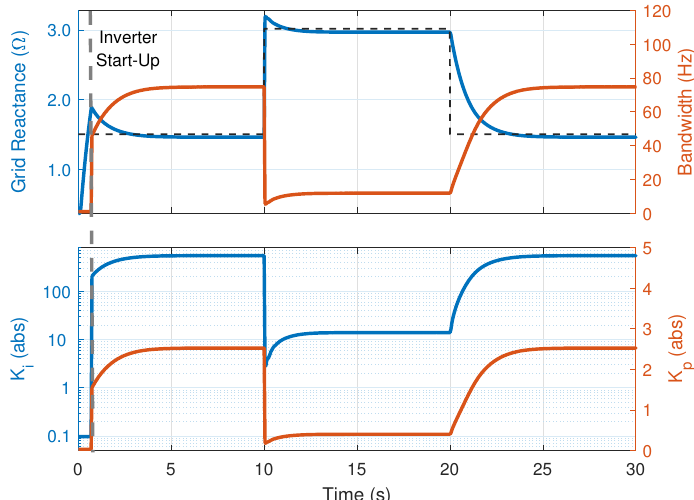
Figure 9. Real-time measurement (blue) of grid reactance, its known value (black dashed), and adaptively adjusted PLL parameters.